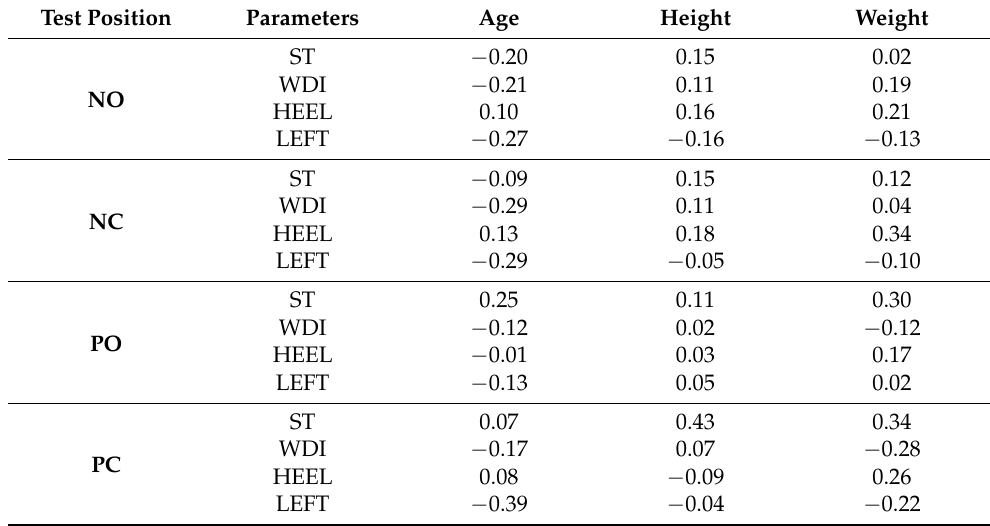
Table 4. Bivariate correlations (r) between anthropometrics and demographics with posture control parameters (ST, WDI, HEEL, LEFT) under four testing conditions (NO, NC, PO,